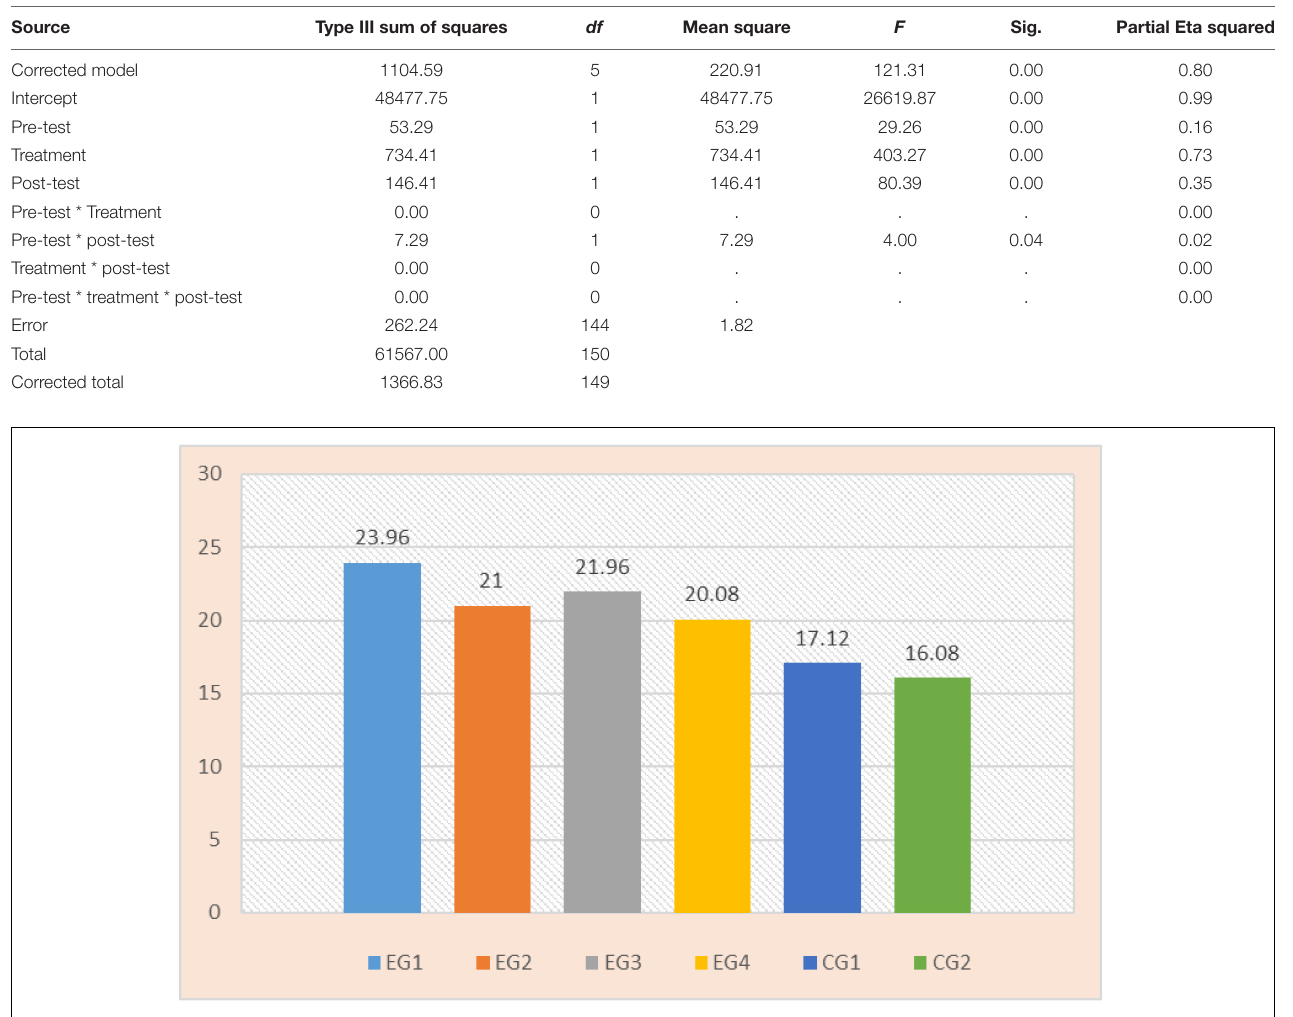
FIGURE 2 | Delayed post-test mean scores of the groups with different ± pre-test, ± treatment, and ± post-test